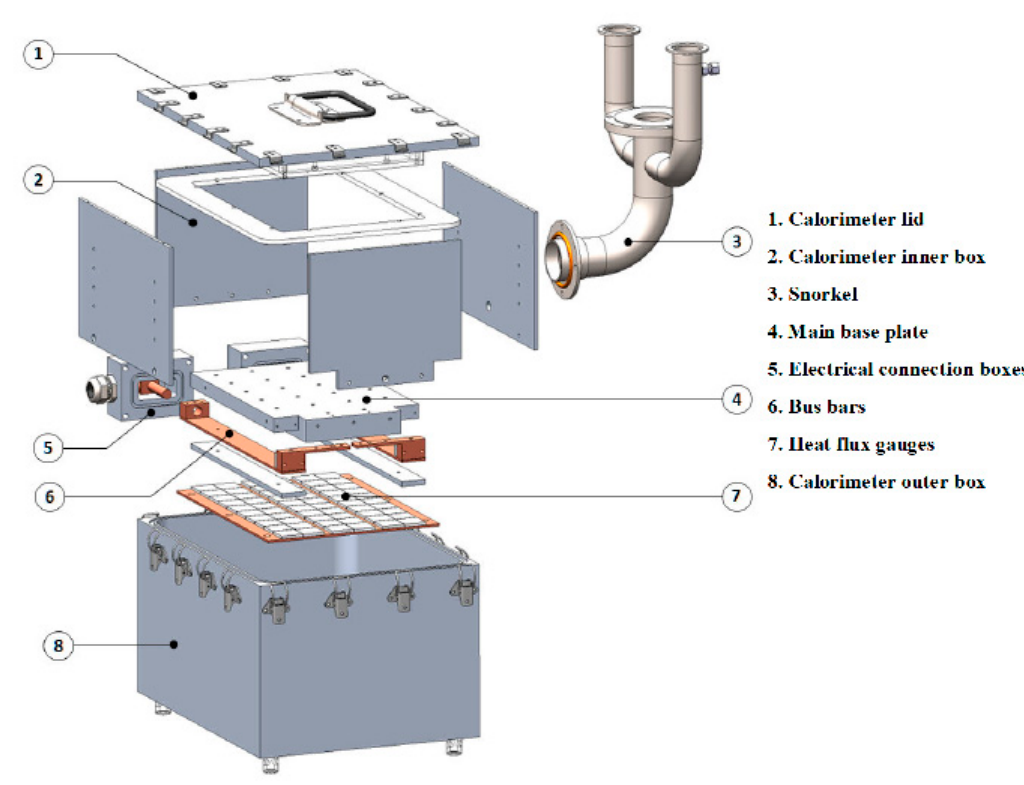
Figure 4. Isothermal battery calorimeter assembly [18].